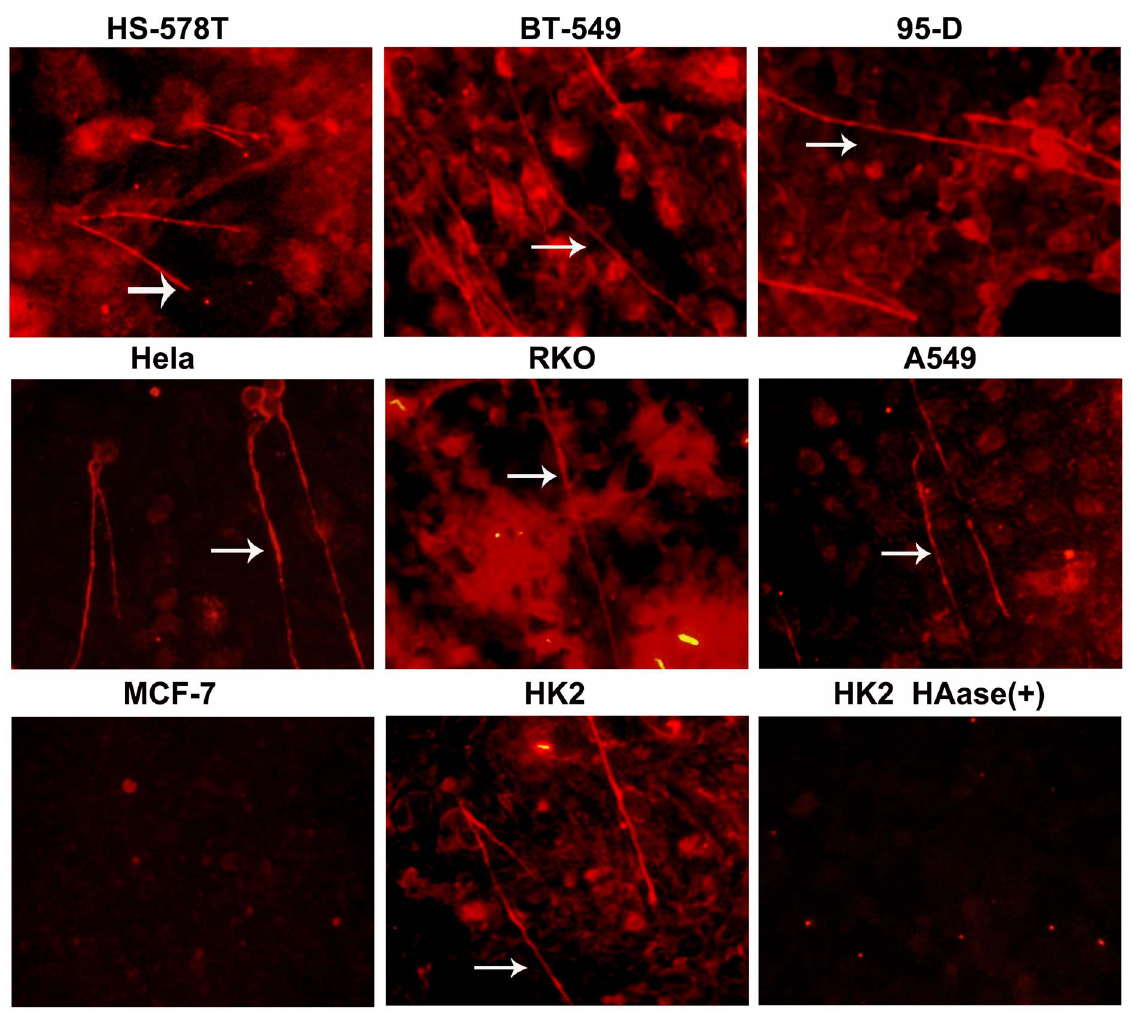
Figure 5. The tumor cell surface HA content is rich, and HA forms cable structures. Confluent monolayer cells were grown in the presence of 10% (v/v) FCS before fixation with methanol and the detection of HA by the addition of bHABP. The sections were imaged by inverted fluorescence microscopy ( 6 20 objective). HA cables are highlighted with white arrows. Original magnification 6 20. Streptomyces hyaluronidase was added to the cells before fixation. The HA cables were degraded without detection.